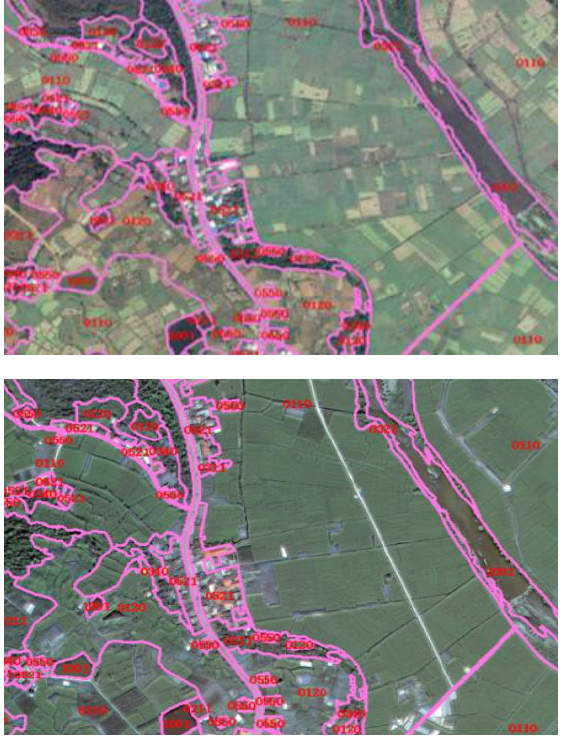
Figure 4 . Missing to collect a new road of two-phase